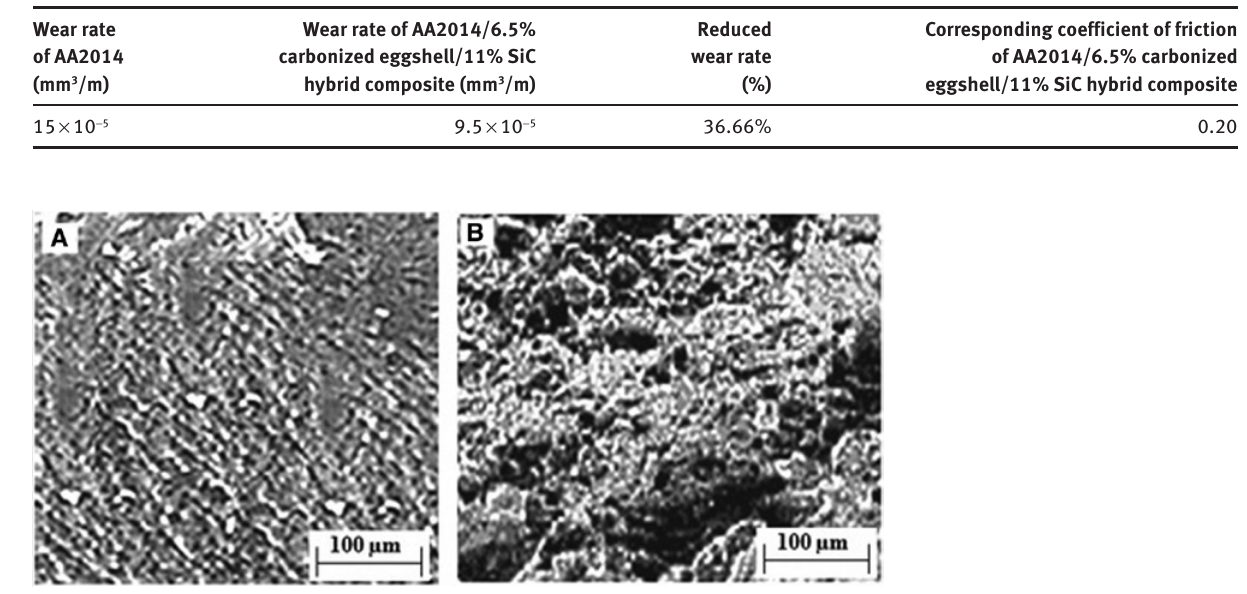
Table 6: Confirmation experimental table for wear rate and coefficient of friction.